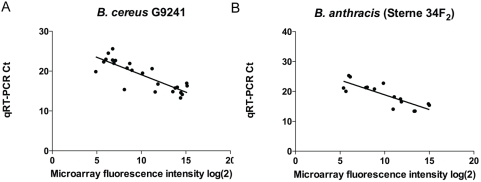
Spearman correlations comparing microarray and SYBR-Green qRT-PCR gene expression results for select genes in two conditions - CO2 and O2.(A) B. cereus G9241; expression for 12 genes in 2 conditions (5 chromosomal, 4 from pBC218, and 3 from pBCXO1); Spearman r = −0.7797; p<0.0001; and (B) B. anthracis Sterne 34F2; 8 genes in two conditions (5 chromosomal, 3 from pXO1); Spearman r = −0.7735; p = 0.0004. Genes and primer sequences listed in Tables S11 and S12.